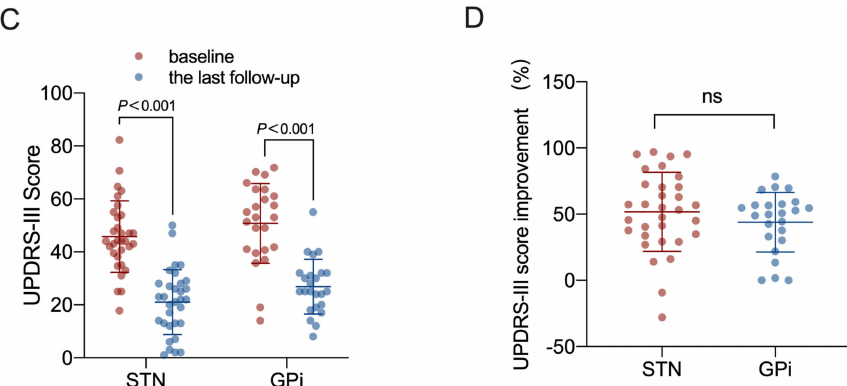
Figure 1. The STN-DBS and GPi-DBS influence on the Med off MDS-UPDRS-III score and UDysRS score in 56 patients who have LID. ( A ) UDysRS scores of GPi-DBS and STN-DBS patients at the last follow-up and baseline. ( B ) Contrast of the improvement of UDysRS score by GPi-DBS and STN-DBS. ( C ) Med off MDS-UPDRS-III scores of GPi-DBS and STN-DBS patients at the last follow-up and baseline. ( D ) Contrast of the improvement of Med off MDS-UPDRS-III score by GPi-DBS and STN-DBS. UDysRS, Unified Dyskinesia Rating Scale; DBS, deep brain stimulation; STN, subthalamic nucleus; GPi, globus pallidus interna; MDS-UPDRS-III, Unified Parkinson’s Disease Rating Scale part III; ns,